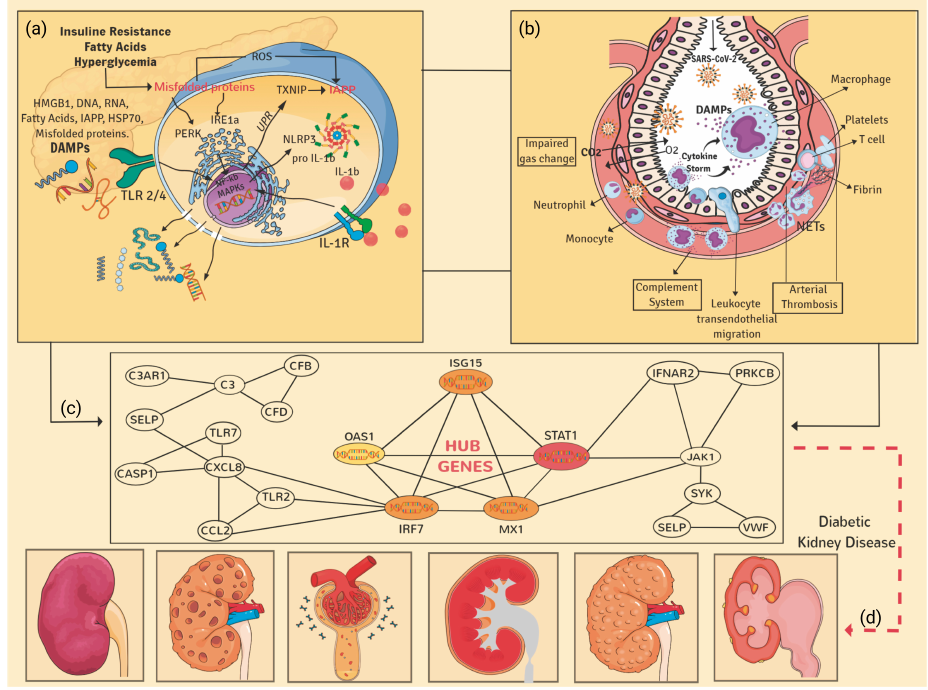
Figure 10. Pathophysiological impact of COVID-19 on DKD condition. ( a ) An illustration that simplifies the multiple processes and proinflammatory pathways that initiate in an orchestrated manner, the primary stage of the chronic inflammatory response in pancreatic cells coupled with the activation of the complement system due to the presence of DAMPs, excessive synthesis of ROS and dysfunction endothelial, contribute to the progression of DM and the development of micro- and macrovascular complications in target organs, ( b ) pathogen-host interaction mechanisms, showing the alveolar microenvironment, where the localized inflammatory response is initiated by the presence of PAMPs and DAMPs, with the consequent endothelial activation, migration of immune cells, significant tissue damage and uncontrolled release of cytokines, as well as proinflammatory interleukins (cytokine storm). ( c ) Predictive hub genes and their impact on the pathophysiological process of diabetic kidney disease and SARS-CoV-2 infection; ( d ) representation of the multiple functional and morphological alterations in renal tissue due to dysfunction of podocytes, epithelial cells, endothelial cells and local macrophages, events that ultimately triggers the development of glomerular sclerosis, hyalinosis, deposition in the mesangial extracellular matrix and local fibrosis, alterations which together increased renal filtration, precipitation of glomerular nephrosis, acute kidney injury and progressive chronic kidney disease (CKD), among others comorbidities.